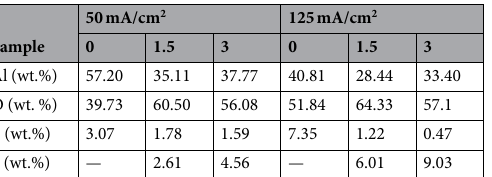
Table 2. EDS results of the PEO coatings formed on an Al-Mg-Si alloy by PEO for 8 min using different concentrations of Na 3 AlF 6 at different current